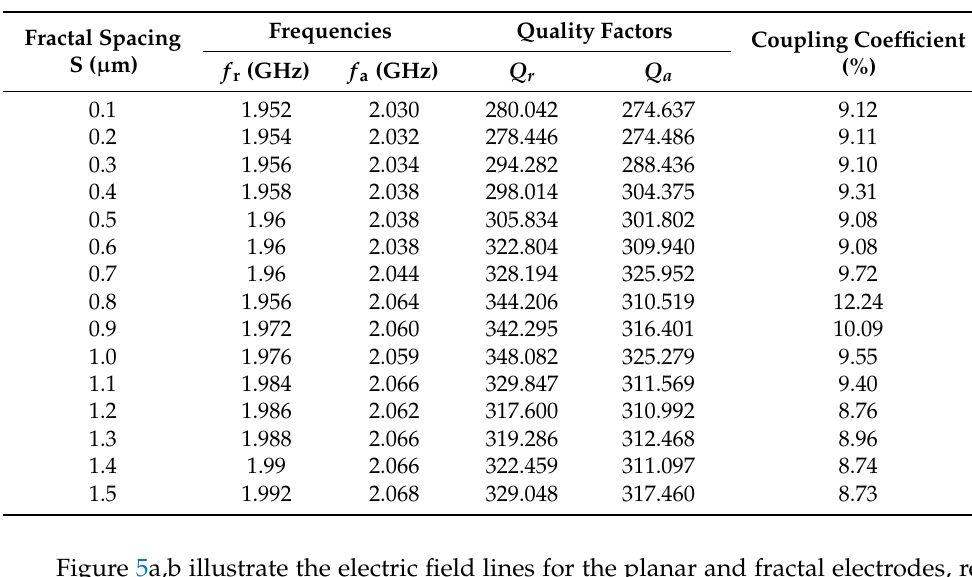
Table 3. Optimization of the fractal gap of the FBAR.